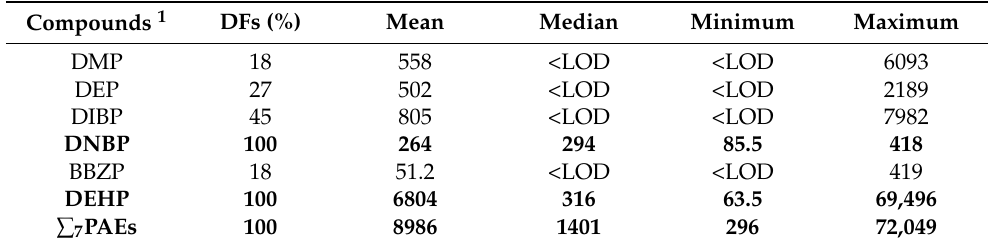
Table 1. Concentrations (ng/g) and detection frequencies (DFs, %) of phthalates in mask samples ( n = 11) purchased from China